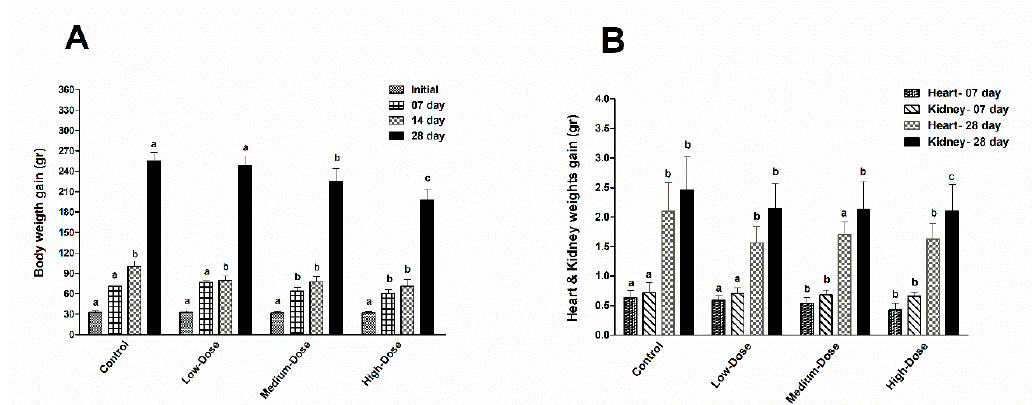
Figure 1. Effects of DB supplementation on the body and organ weight gain (gr) of chickens. ( A ) Body weight of chickens at 0, 07, 14, 28 days of age (n = 10). ( B ) Organ weights of chickens at day 7 and day 28 of age (n = 10). Data are presented as mean value ± SEM. Values without the same mark (a, b, c) represent statistically significant differences ( p < 0.05). Subfigure A uses line graphs with experimental days on the X -axis for body weights, and subfigure B separates the data into two bar graphs for heart and kidney, respectively.